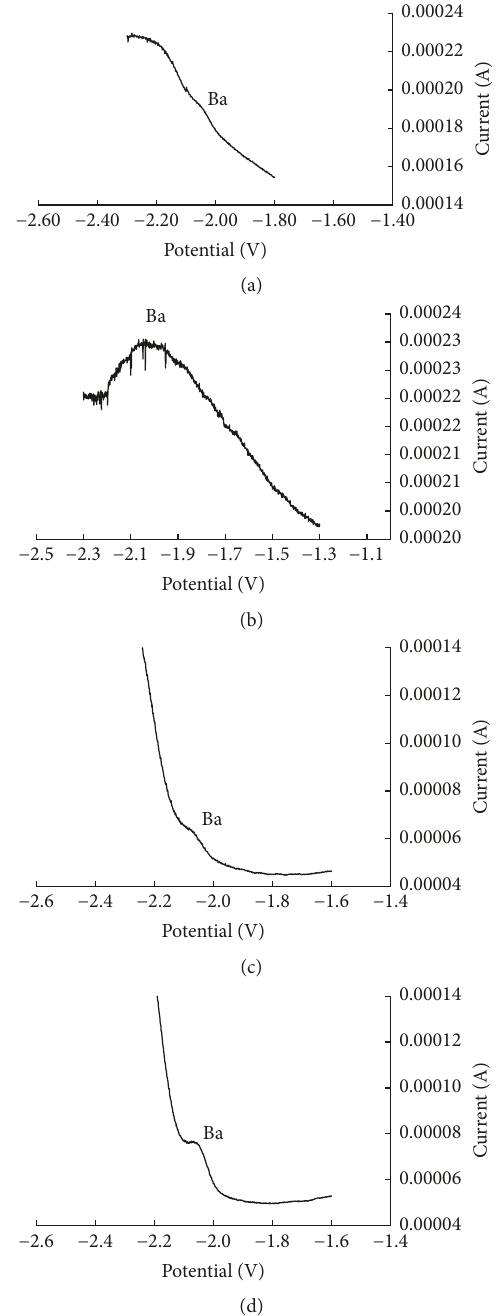
Figure1:Investigationofthreedifferentelectrodes;top(a)baregold (conditioned), second top (b) bare bismuth (conditioned), third top (c) glassy carbon (preconditioning), and last (d) glassy carbon (postconditioning). Voltammetric parameters: differential pulse, 10 𝜇 g/L Ba, 0.02 M KCl electrolyte with 5mg/L Hg (0.0015M HNO t dep = 30 sec, dp= -2500 mV, 100